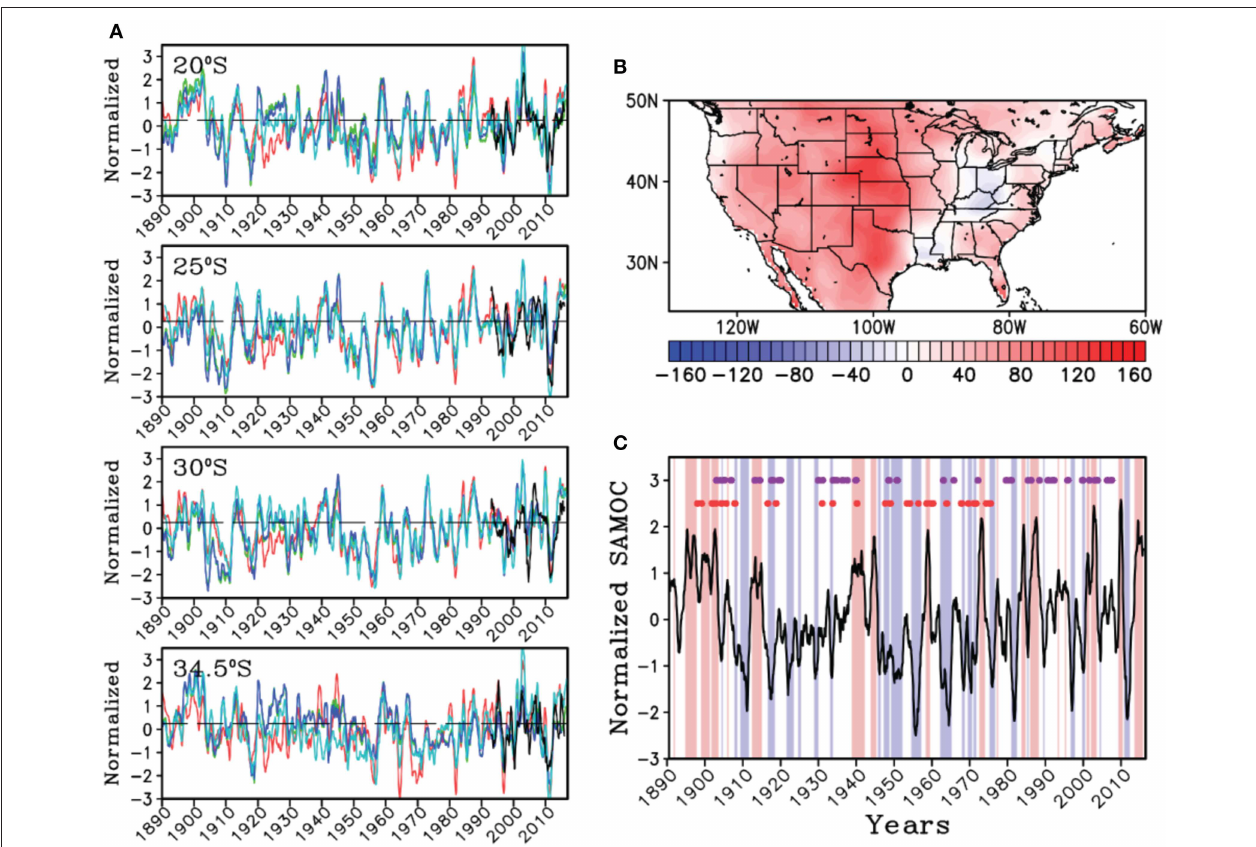
FIGURE 10 | (A) Reconstructed South Atlantic MOC at four different latitudes from 1870 using XBT, satellite altimetry observations (black), and SST from HadSST(red), ERSSTv4 (green), ERSSTv3 (blue), and COBE-SST (cyan). (B) Percentage change in the number of heat waves during weak minus strong South Atlantic MOC when the MOC leads heat waves by 30 years. (C) Reconstructed South Atlantic MOC from HadSST at 30 ◦ S (black) with periods of strong (weak) MOC red (blue) shading. The historical US heat waves are shown by the purple dots (red dots are lagged by 30 years to show the correspondence of weak MOC and more heat wave events 30 years